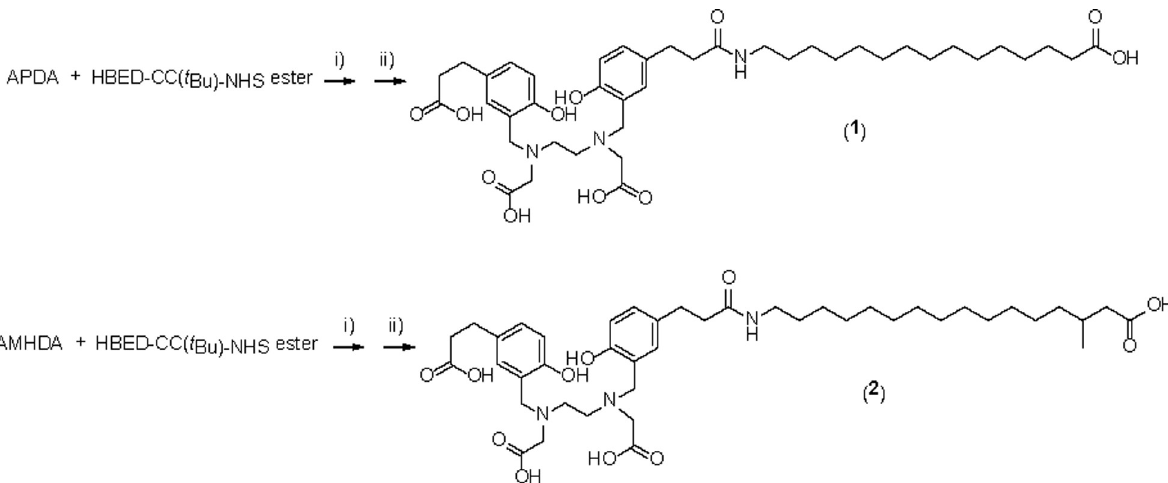
Fig 2. Synthesis of HBED-CC-PDA (1) and HBED-CC-MHDA (2). i) DIPEA, dichloroethane, 50˚C, 2 h; ii) TFA, rt, 2 h.